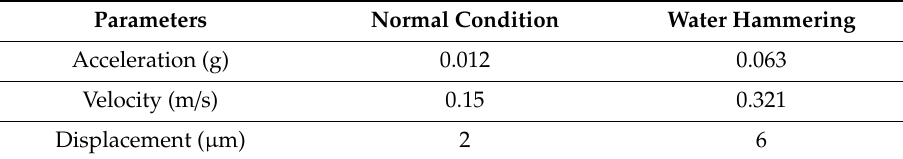
Table 5. Vibration analysis